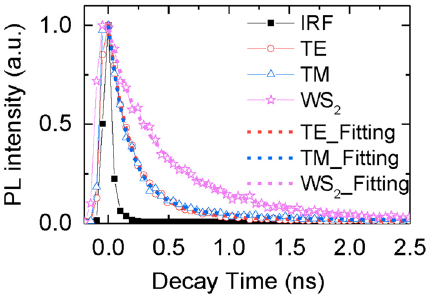
Figure 8. Time and polarization-resolved PL spectra of the bare WS 2 (pink star curve) and the hybrid nanostructure. PL lifetimes of the TE and TM polarizations of the hybrid nanostructure are indicated by the red dot (TE) and blue triangle (TM) curves. Data are fitted by two-component exponentials (dashed curves with the corresponding color).